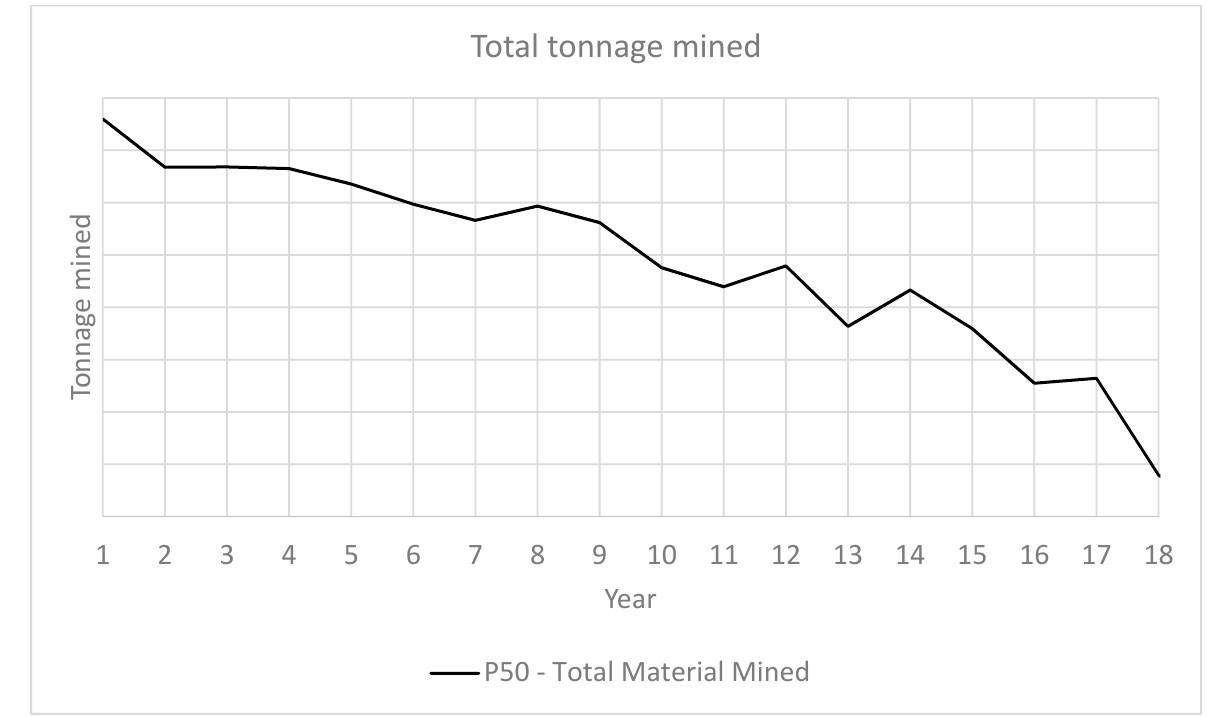
Figure 3. Total ore tonnage mined and recovered gold from the three mines at the RGM mining complex.